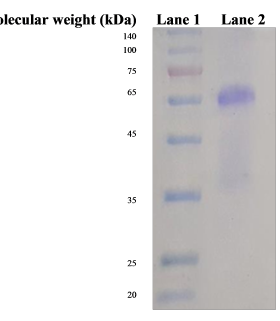
Fig. 2. SDS-Page of ANAE enzyme where Lanes 1 indicated molecular marker, whereas Lane 2 referred to purified ANAE.